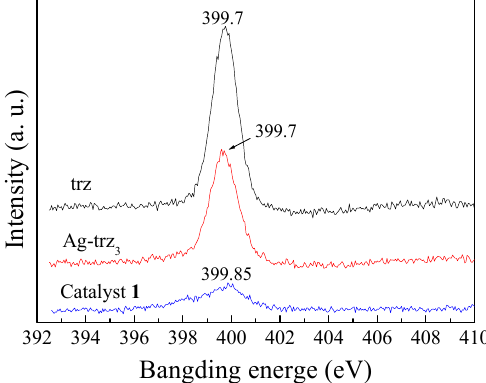
Figure 10. X-ray photoelectron N1 spectra of catalyst 1 , Ag-trz 3 and trz. Figure 10. X-Ray photoelectron N1 spectra of catalyst 1 , Ag-trz 3 and trz.